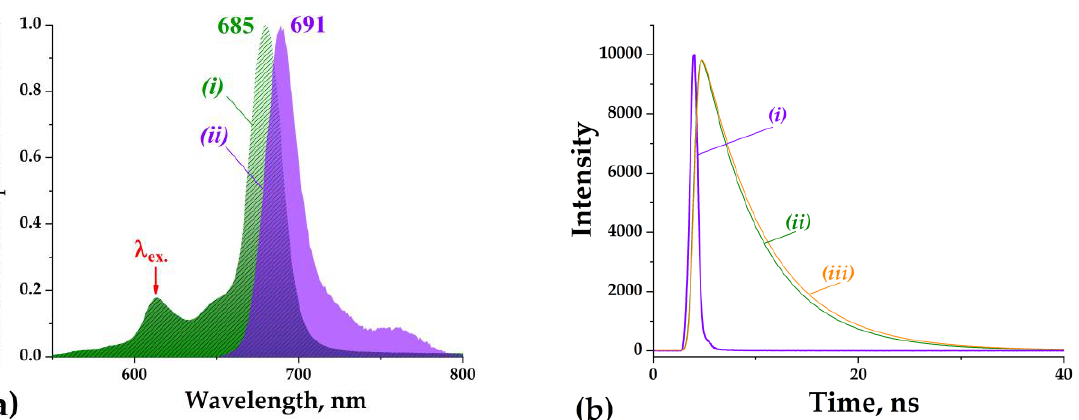
Figure 4. ( a ): Electron absorption ( i ) and fluorescence ( ii ) spectra for compound 4 in chloroform; ( b ): Fluorescence decay curves for compounds 4 ( ii ) and 9 ( iii ) in chloroform and LUDOX solution in water (standard) ( i ).